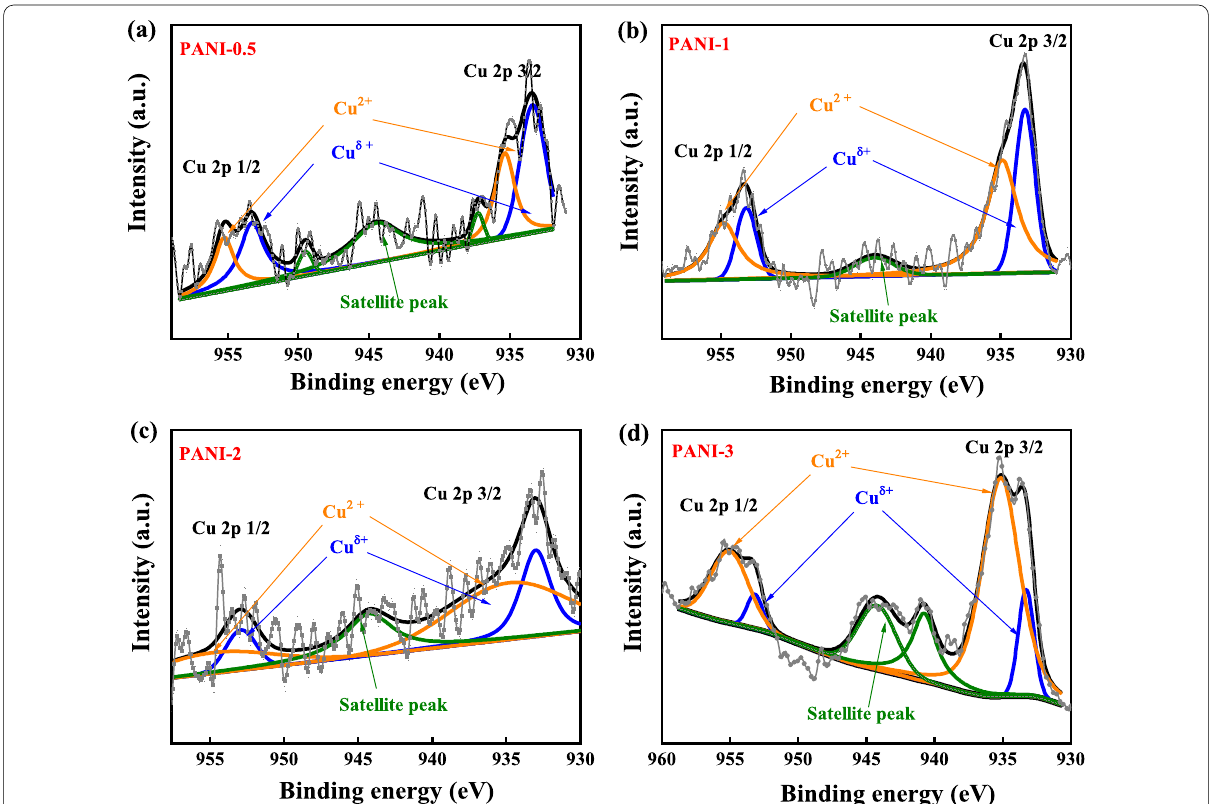
Fig. 5 XPS spectra of Cu 2p spectrum for a PANI-0.5, b PANI-1, c PANI-2, and d PANI-3 porous films